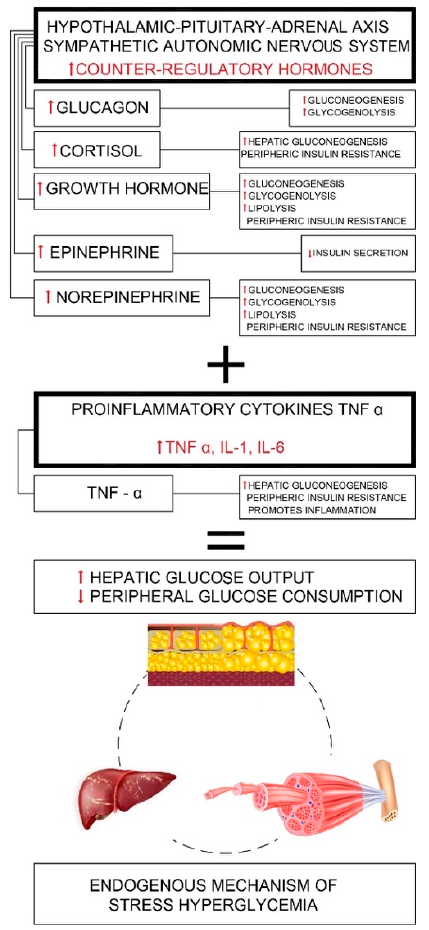
Appendix Figure 1. Endogenous mechanism of stress hyperglycemia. Figure A1. Endogenous mechanism of stress